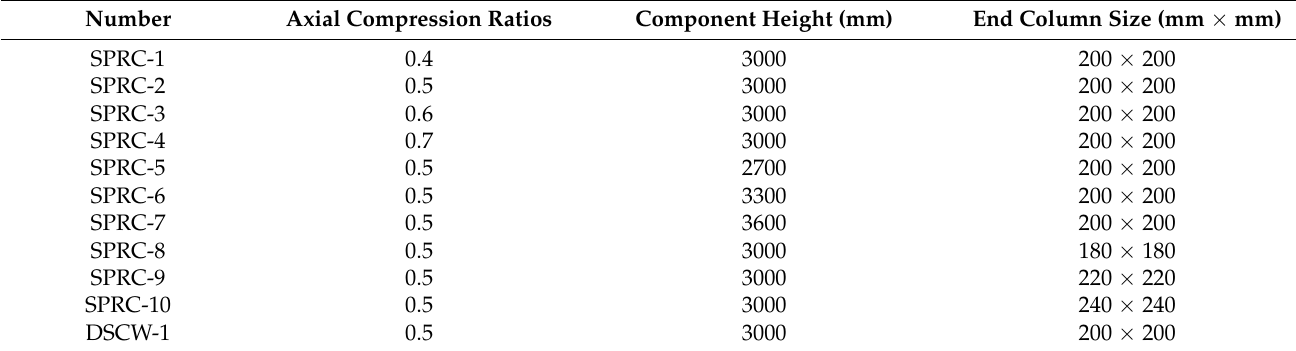
Table 3. Relevant parameters of each